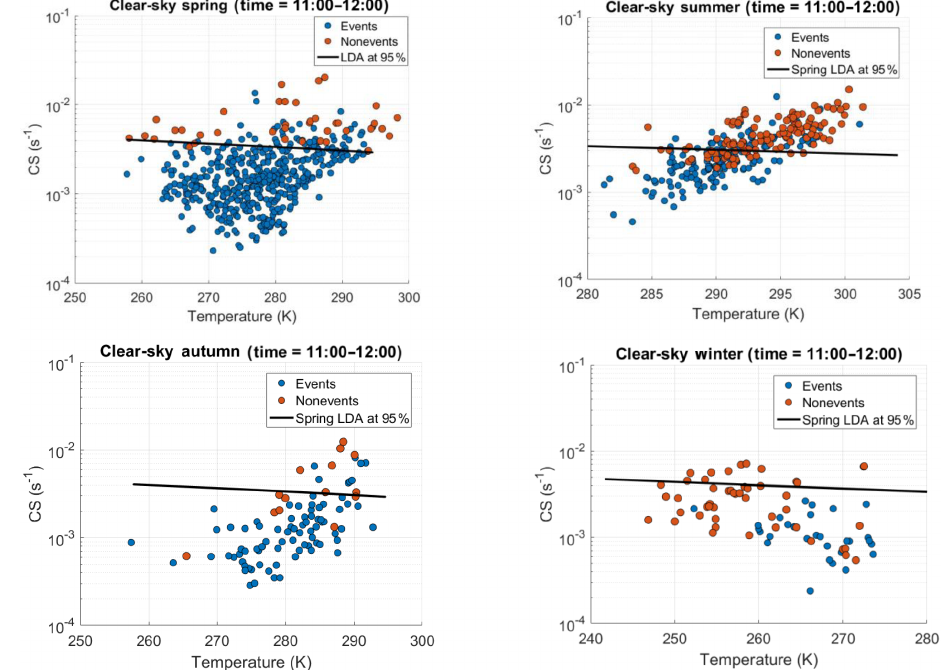
Figure 12. Relationship between CS and temperature (time window: 11:00–12:00) NPF clear-sky event days and nonevent days. Horizontal line is calculated from spring LDA at 95% confidence relative to nonevents and is demonstrated by Eq. (6).